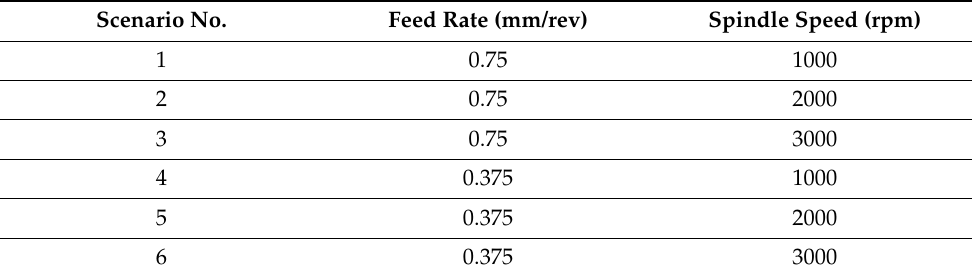
Table 4. Drilling parameters for the six FEA